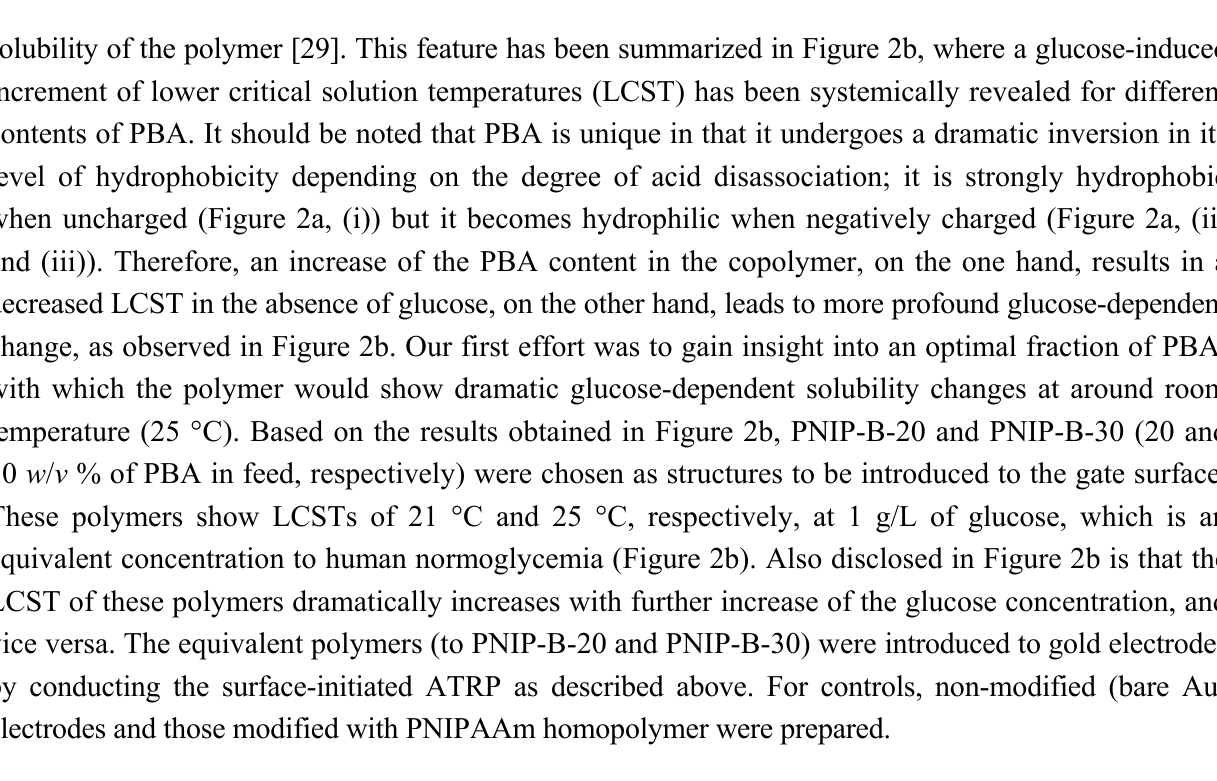
Figure 2. ( a ) Glucose-dependent equilibria of PBA. ( b ) Glucose dependent changes in the lower critical solution temperatures (LCST) of PNIP-B for different contents of